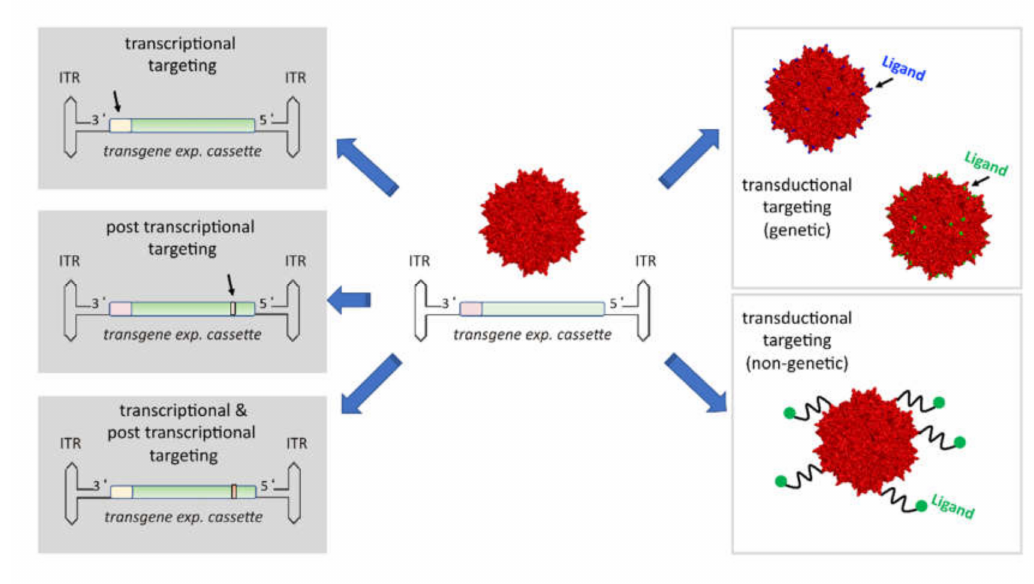
Figure 1. Targeting strategies. In order to restrict transgene expression to distinct cell types, i.e., in the context of cancer gene therapy towards the malignant cell, distinct cell types of the tumor stroma or cells from which factors are secreted like muscle cells or hepatocytes so called targeting strategies have been developed. Of note, targeting strategies focusing on the vector genome can be combined with strategies focusing on modifying the capsid. Vectors based on natural serotype capsids do show a broad tropism albeit tissue preferences such as those discussed for the liver are present. By combining destruction or shielding of natural receptor binding epitopes on the capsid with the introduction of—for the AAV—“foreign” molecules that mediate cell binding and internalization, tropism is re-directed towards a novel vector–receptor interaction. This also impacts on biodistribution, is expected to lower the risk of unspecific uptake in o ff -target tissues and anti-AAV immune responses. This targeting strategy—known as transductional targeting—is either inserting ligands or cell surface receptor binding molecules genetically or via covalent or non-covalent coupling to the AAV capsid. Both transcriptional and post-transcriptional targeting strategies modulate production of the transgene product, i.e., these strategies do not impact on vector biodistribution. Specifically, in transcriptional targeting approaches natural or synthetic promoters are used to restrict transgene expression in a way that ideally no o ff -target expression takes place. Alternatively, or in combination with transcriptional targeting, post-transcriptional targeting strategies are applied. In post-transcriptional targeting strategies microRNA targeting sites are used, which when recognized by the corresponding microRNA are leading to the degradation of the microRNA target sites containing mRNA. Since microRNAs are frequently downregulated in malignant cells, post-transcriptional targeting strategies are successfully applied to avoid expression in hepatocytes or other healthy cell types that are prone to damage when expressing the therapeutic transgene. ITR = inverted terminal repeats. Vector genomes are shown schematically with ITRs, promoter and transgene plus poly A sequences. Arrow marks position of promoter or microRNA targeting sites, respectively. Promoter: red = ubiquitously active; yellow = restricted activity. Positions marked in blue on the capsid refer to the tip of the highest capsid protrusion, while green shows the tip of the second highest protrusion. Both peaks are used for genetic insertion of peptide ligands (see main text for